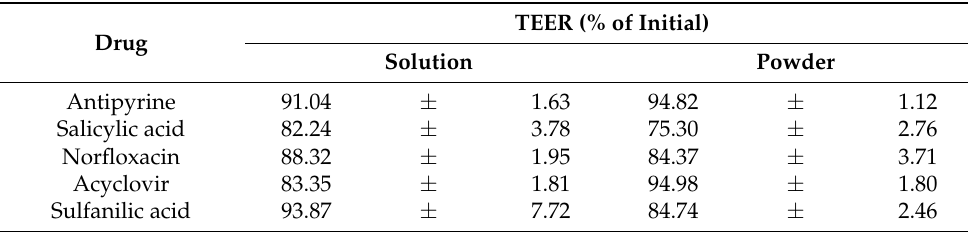
Table 5. Transepithelial electrical resistance (TEER) values of Calu-3 cell layers following drug application as solution and powder dosage